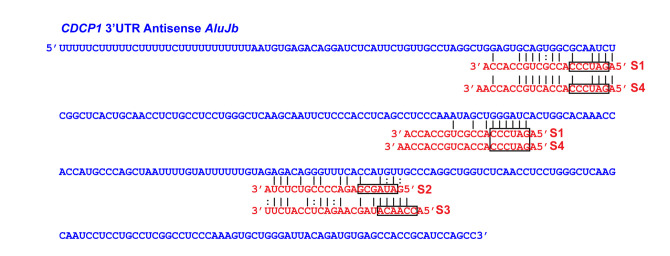
Predicted binding sites of Alu siRNAs in the 3′UTR of CDCP1 mRNAs. One putative target site of Alu siRNA-S2 or -S3 is located in the antisense AluJb located in the CDCP1 3′UTR. Two potential binding sites of Alu siRNA-S1 or -S4 are located in the CDCP1 3′UTR. Black box: seed sequence. The AluJb in the CDCP1 3′UTR located at chr3:45083628–45083942. S2 and S3 Alu siRNAs most likely originated from their target site regions of the corresponding sense Alu strand. Similarly, S1 and S4 Alu siRNAs likely originated from their first (upstream) target site regions of the corresponding sense Alu strand.